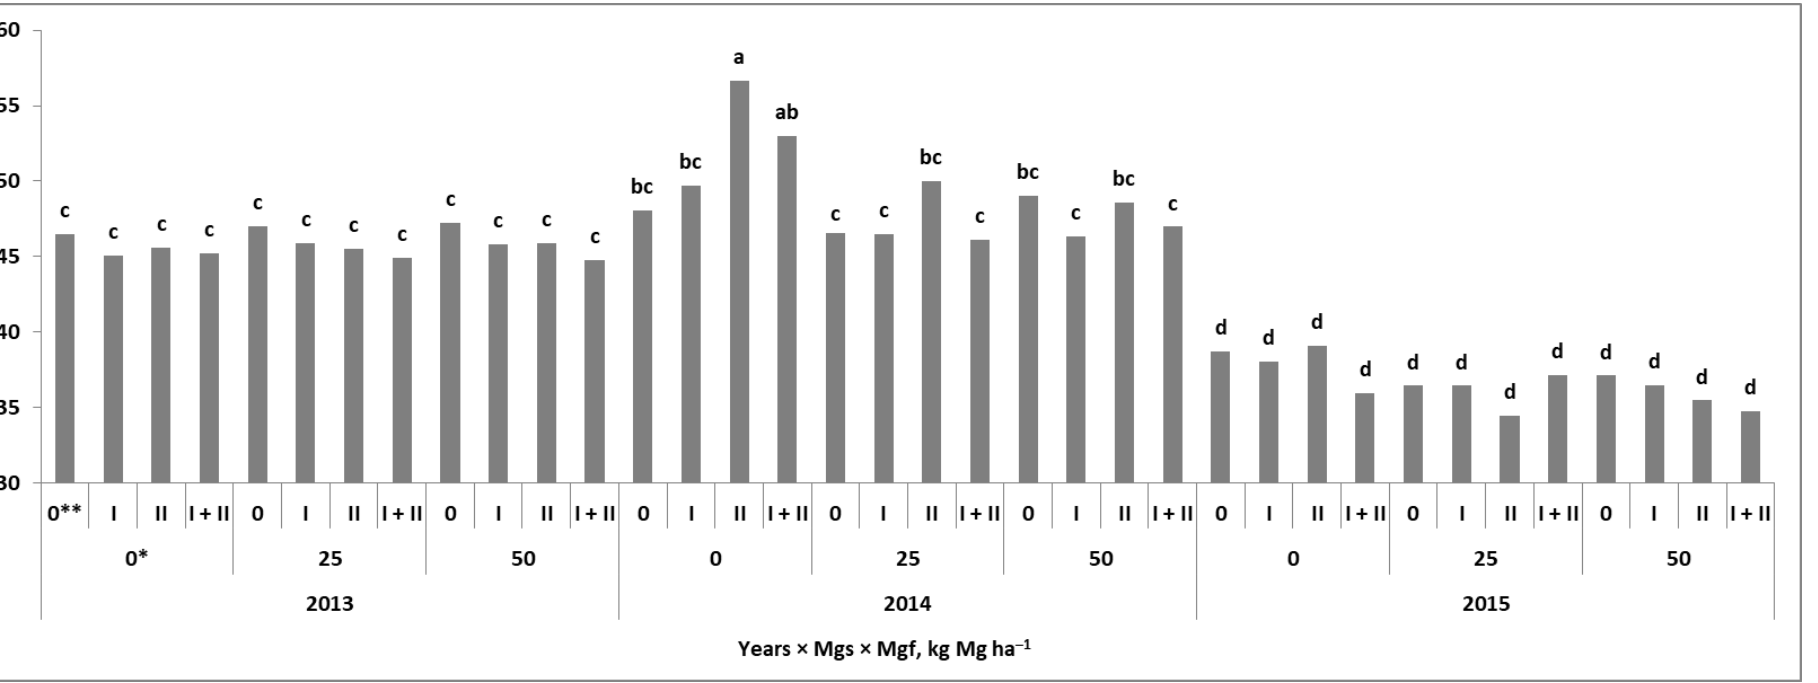
Figure 5. The nitrogen unit productivity of grain in response to the interaction of Mg fertilization systems and years. a, b, c, d Similar letters mean a lack of significant differences using Tukey’s test. Mgs and Mgf— soil and foliar Mg fertilization system, respectively. * Doses of applied Mg, kg ha – 1 ; ** stages of Mg foliar fertilization to wheat: IBBCH — 30; II — BBCH 49/50.